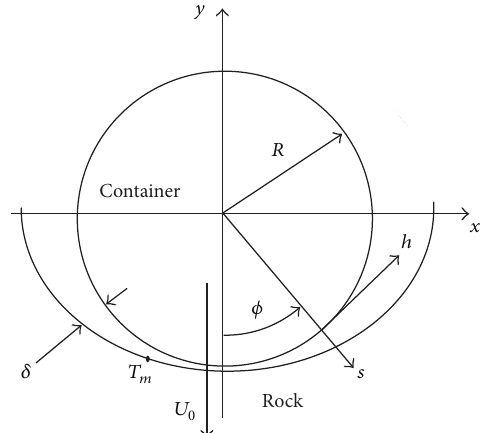
Figure 4: Physical model and coordinates for melting of sphere container in